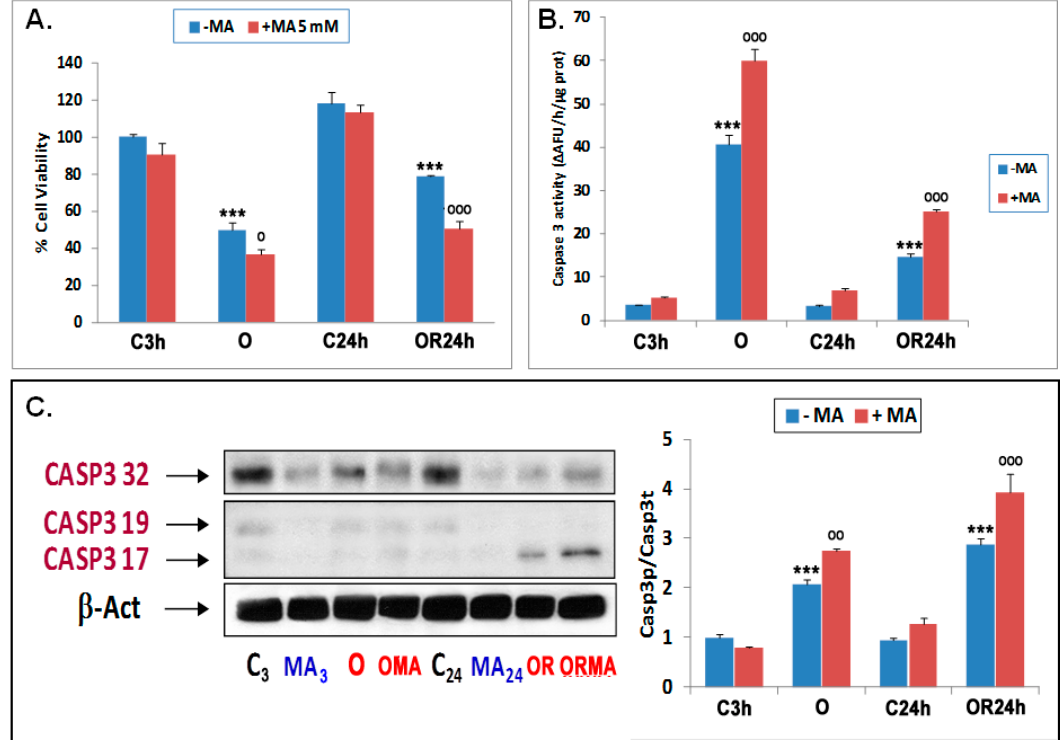
Figure 2. E ff ect of 3-methyladenine (3-MA) on cell viability and apoptosis of cortical neuron cultures under OGD and OGDR conditions. ( A ) E ff ect of 3-MA on cell viability measured by XTT assay. ( B ) E ff ect of 3-MA on caspase-3 activity. Both measurements were performed in extracts of cortical neurons subjected to 3 h OGD exposure (O) and 24 h OGDR (OR). Basal caspase-3 activity (C3h) was 3.58 ± 0.05 ∆ AFU / h / µ g protein. ( C ) E ff ect of 5 mM 3-MA on caspase-3 proteolysis in cortical neuron cultures under control conditions (C 3 and C 24 ) and OGD (O) and OGDR (OR) treatments. Western blots (CASP3 32 kDa; tCasp3 = total caspase 3) and cleaved (CASP3 19,17 kDa; pCasp3 = proteolyzed caspase 3) were performed in extracts of cortical neurons subjected to 3 h OGD exposure and 24 h OGDR, using two di ff erent anti CASP3 antibodies. Left: Representative CASP3 Western blots are shown. Right. Quantification of Western blot results showing the ratios between Casp3p = proteolyzed caspase and Casp3t = total caspase 3. Data are expressed as ratios over basal control and are mean ± SEM of three experiments, each of which was performed in triplicate ( A , B ) or duplicate ( C ). Statistics compare the e ff ect of O and OR versus their respective controls (***) or the e ff ect of 5 mM 3-MA under each condition versus respective conditions in the absence of this compound ( ooo ) at o p < 0.05, oo p < 0.01, ooo p < 0.001; one-way ANOVA test) are shown. C3h: control 3h; C24h: control 24h; OR24h: OGDR 24h; OMA: OGD plus 3-MA; ORMA: OGDR plus 3-MA; C 3 : control 3h; MA 3 : 3-MA 3h; MA 24 : 3-MA